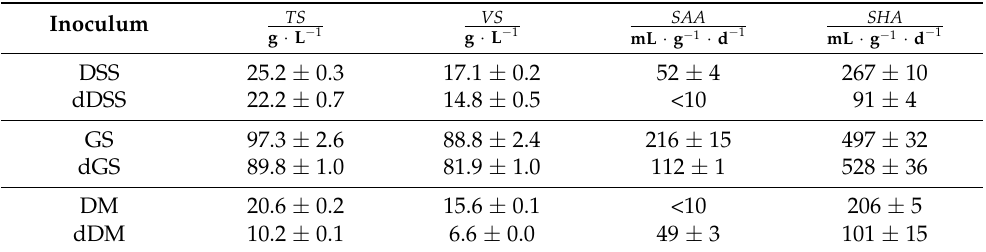
Table 1. Solids content and SMA of DSS, GS and DM, before and after the degassing process (dDSS, dGS and